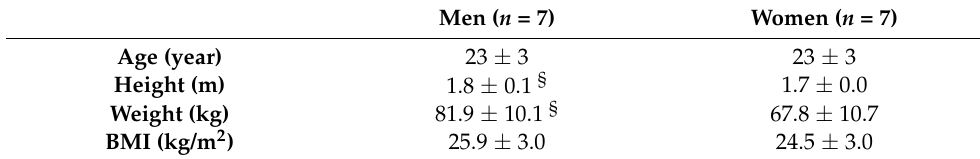
Table 1. Participant characteristics ( n = 14; Men = 7, Women = 7).